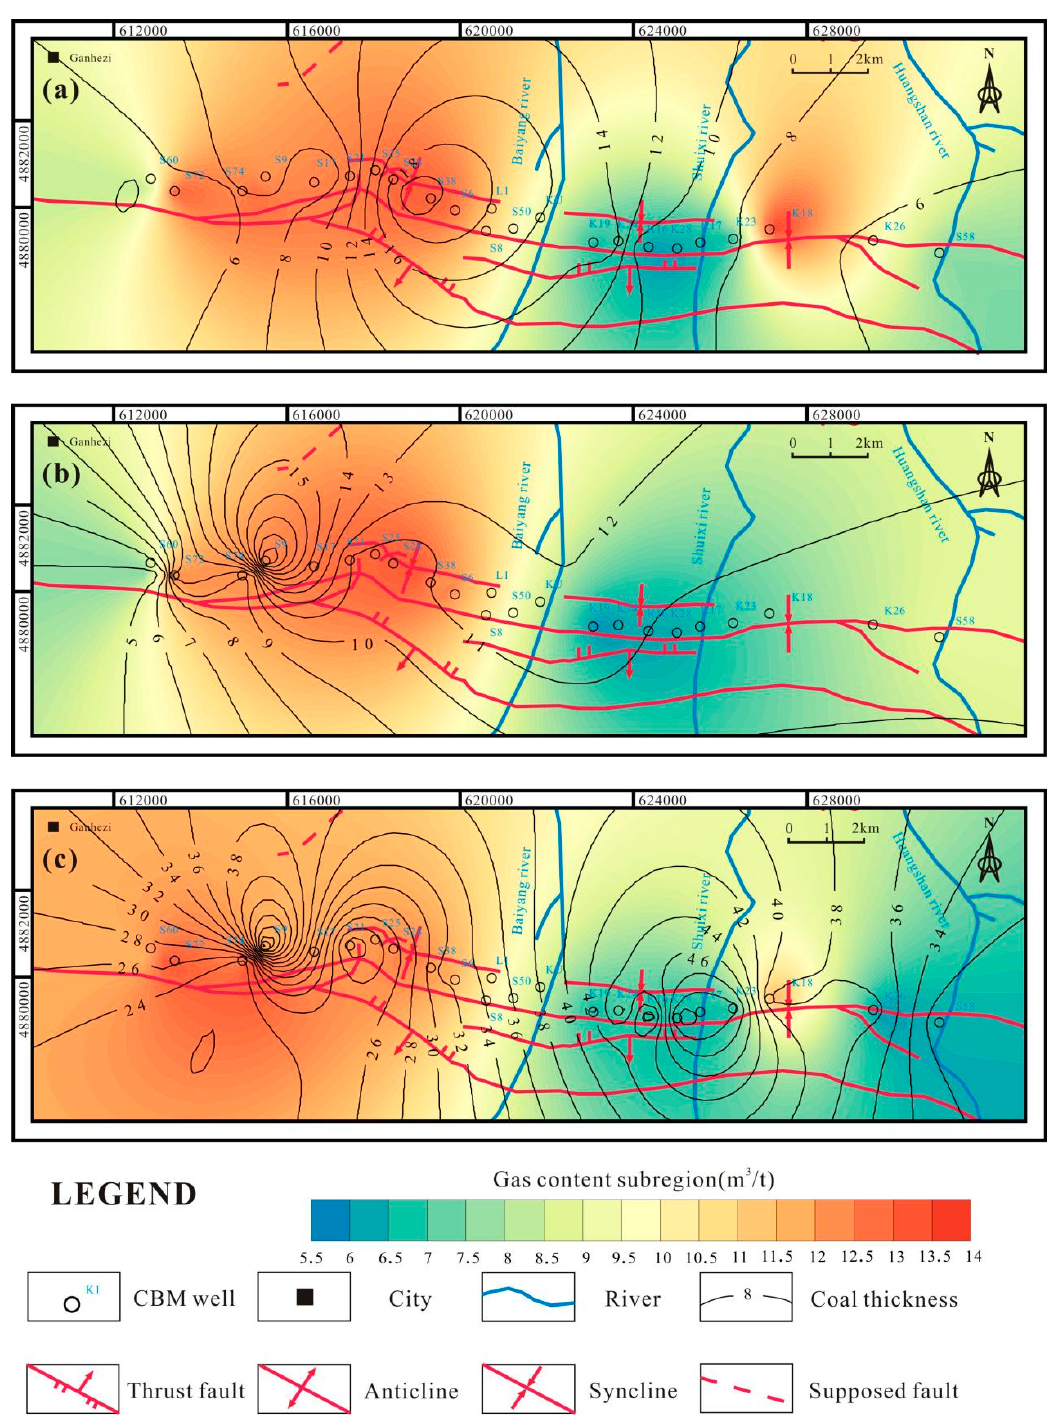
Figure 7. Relationship between gas content and coal thickness of Nos. 39 ( a ), 41 ( b ), and 42 ( c ) coal seams in the Ergonghe syncline (units of contour lines: m for coal thickness and m 3 /t for gas content with different color areas).